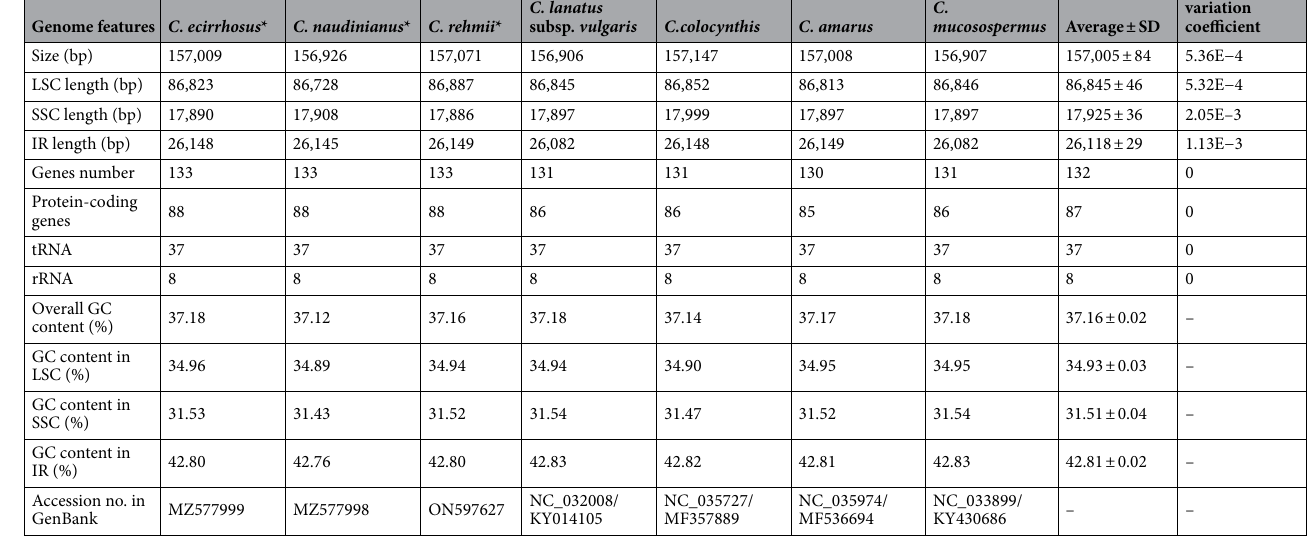
Table 1. Summary statistics for the assembly of seven CPGs in the genus Citrullus . LSC Large single copy, SSC small single copy, IR inverted repeat. *Indicated the chloroplast genome of species was assembled in the